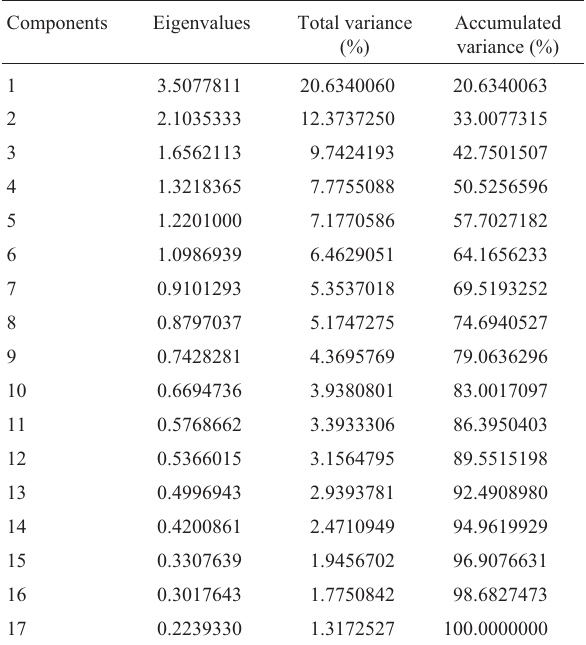
Table 3 - Eigenvalues associated to the principal components, their rela- tive and accumulated (%) variances, referring to 17 agromorphological descriptors evaluated in 116 common bean accessions of the IAC Germ- plasm